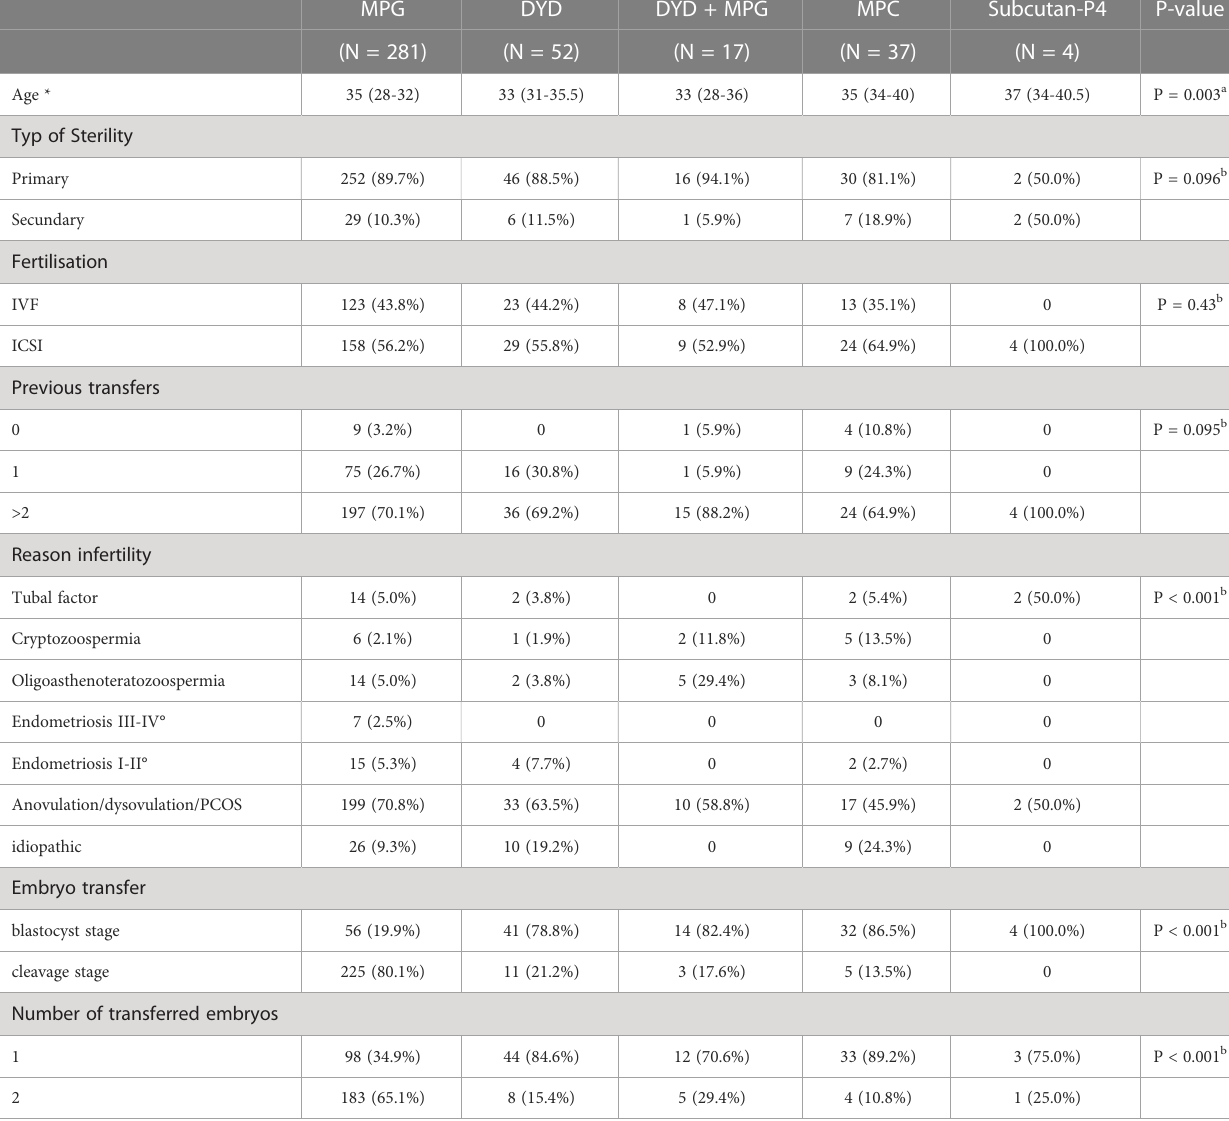
TABLE 1 Demographic characteristics of the study